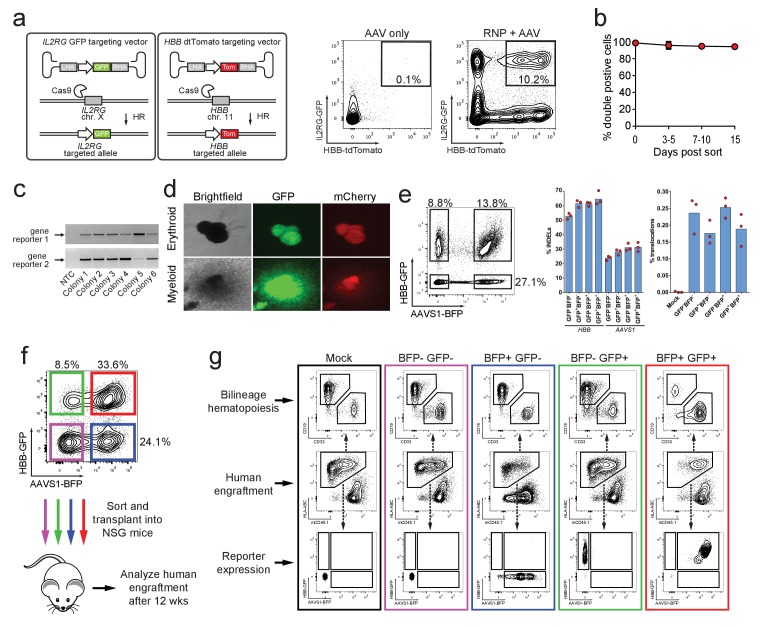
Identification, enrichment, and long-term engraftment in NSG mice of di-genic genome-edited CD34+ human hematopoietic stem and progenitor cells (HSPCs).(a) Left, Schematic depicting HBB and IL2RG di-genic targeting. Middle, FACS plot of an ‘AAV only’ sample at day four post electroporation, showing low episomal reporter expression (HBB-tdTomato and IL2RG-GFP) in cells without the CRISPR system. Right, FACS plot at day four post-electroporation of HSPCs electroporated with Cas9 RNP targeting both HBB and IL2RG followed by transduction with HBB-tdTomato and IL2RG-GFP rAAV6 donors showing the generation of tdTomatohigh/GFPhigh cells with di-genic targeting at HBB and IL2RG. (b) Double-positive HSPCs targeted at HBB (GFP) and CCR5 (mCherry) were sorted at day four post-electroporation and cultured for 15 days while analyzing reporter expression. Error bars represent S.E.M. (N = 3 different HSPC donors). (c) Representative gel images showing PCR genotyping of six (out of 57 total) HBB-GFPhigh (gene reporter 1)/CCR5-mCherryhigh (gene reporter 2) methylcellulose-derived clones confirming integration at each locus (d) Representative fluorescence microscopy images of methylcellulose-derived clones with di-genic targeting at HBB and CCR5 show myeloid and erythroid progenitors with both GFP and mCherry expression. (e) HSPCs were targeted at the HBB and AAVS1 loci with a GFP and BFP expression cassette, respectively. Representative FACS plot (left panel) shows analysis seven days after targeting. All four gated populations were sorted and genomic DNA was subject to TIDE analysis for determining INDEL frequencies at the two loci (middle panel), and subject to ddPCR quantification of one of the two possible monocentric translocations between HBB and AAVS1 (right panel) (see also Figure 3—figure supplement 2). (f) Representative FACS plots from cells targeted at the HBB and AAVS1 loci with a GFP and BFP expression cassette, respectively. Representative FACS plot shows analysis four days after targeting at which point the four populations were sorted and transplanted intrafemorally into NSG mice that were irradiated 24 hr before transplantation. (g) Bone marrow from the injected femurs from the mice transplanted as described in (f) was analyzed 12 weeks after transplantation. Representative FACS plots are from a mouse from each of the four groups depicted in (f) as well as a mouse transplanted with mock-electroporated cells. The middle row depicts human engraftment gated as positive for the human leukocyte antigen complex (HLA-ABC). The upper and lower rows depict FACS plots gated from the human populations and show myeloid (CD33+) and lymphoid (CD19+) engraftment (upper row) as well as reporter gene expression (lower row) (see also Figure 3—figure supplement 3 for all transplantation data).